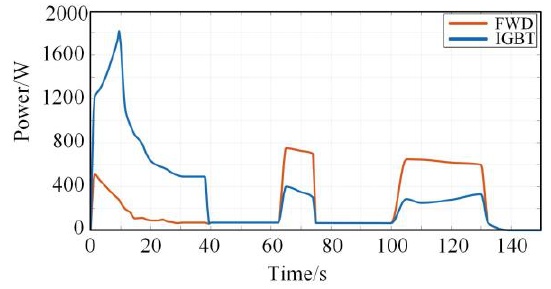
Figure 10. Power loss curve of IGBT and FWD.